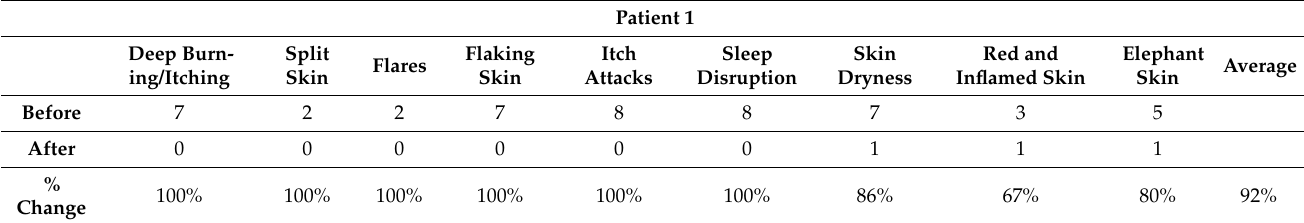
Figure 3. Percentage of symptoms that improved, regressed, or did not improve. This was done as a total of all the symptoms that the patients who finished the study (1–5) were dealing with. Table 3. Severity scores for Patient 1 before and after completing the study. The numbers in the table are out of ten, with ten being the worst severity, and zero meaning the symptom has ceased to exist. The percentage change in the severity of each symptom is shown in the bottom row.